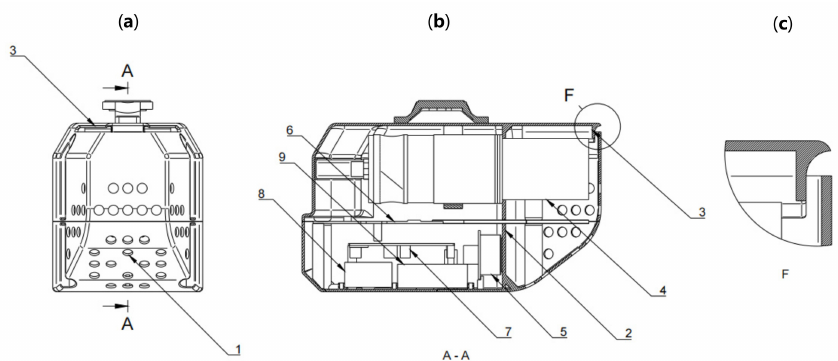
Figure 1. ( a ) Frontal view of the payload enclosure; ( b ) sectional view; ( c ) regional zoomed-in